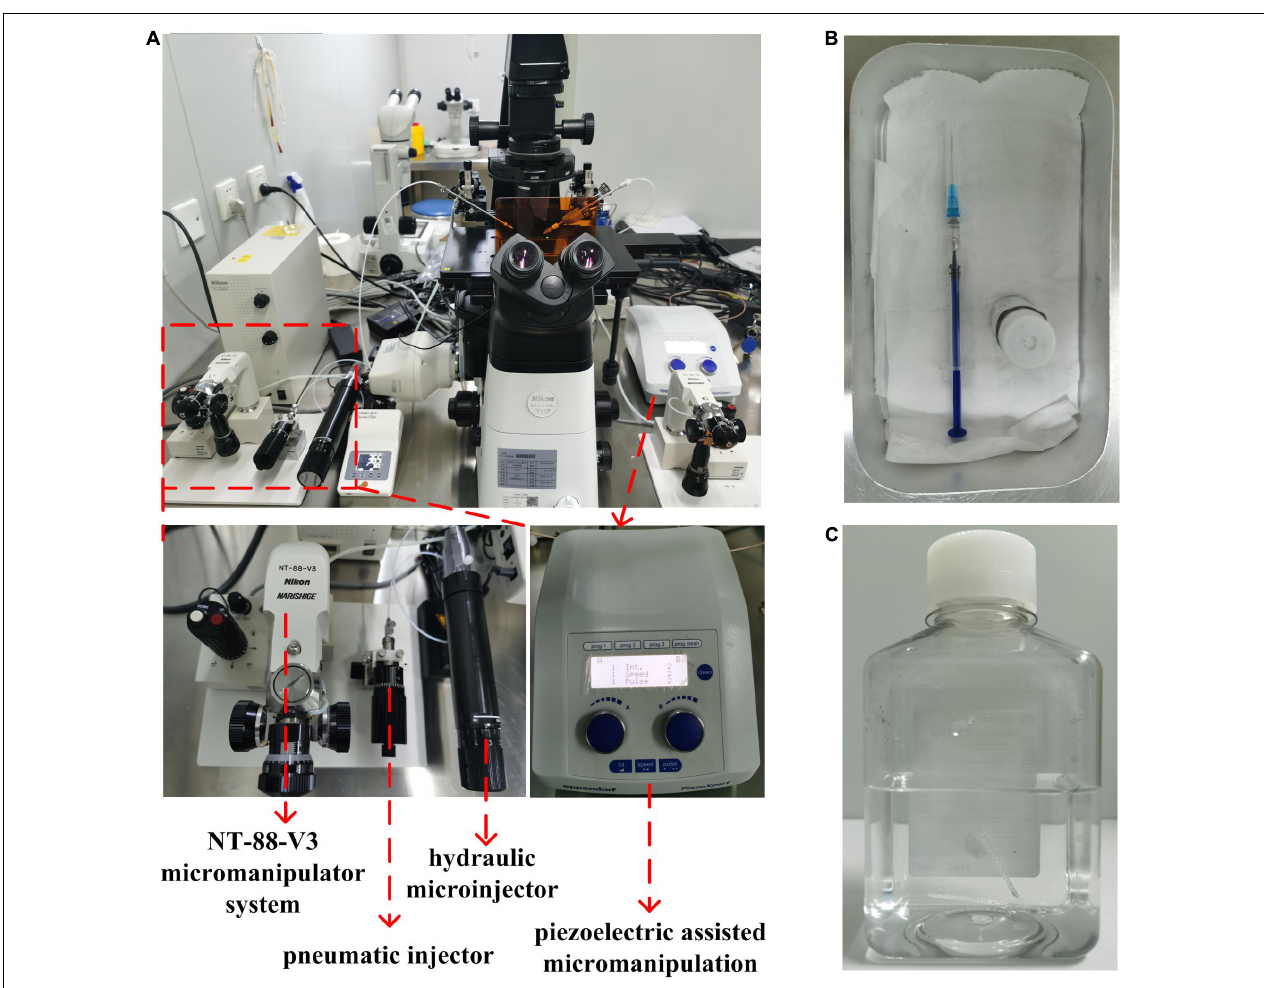
FIGURE 3 | The microinjection equipment used in this study. (A) An inverted microscope, a micromanipulator system (Narishige NT-88-V3, Japan), a pneumatic injector (IM-9C, Narishige, Japan), an oil hydraulic manual microinjector (CellTram Oil, Eppendorf AG, Hamburg, Germany), and a piezoelectric-assisted micromanipulation (PiezoXpert, Eppendorf AG, Hamburg, Germany) were the microinjection equipment used in this study. (B) The mercury covered with water is stored in a glass bottle and added to the microinjection pipette in an aluminum dinner bucket with a syringe. (C) The microinjection needles were recycled in a bottle filled with